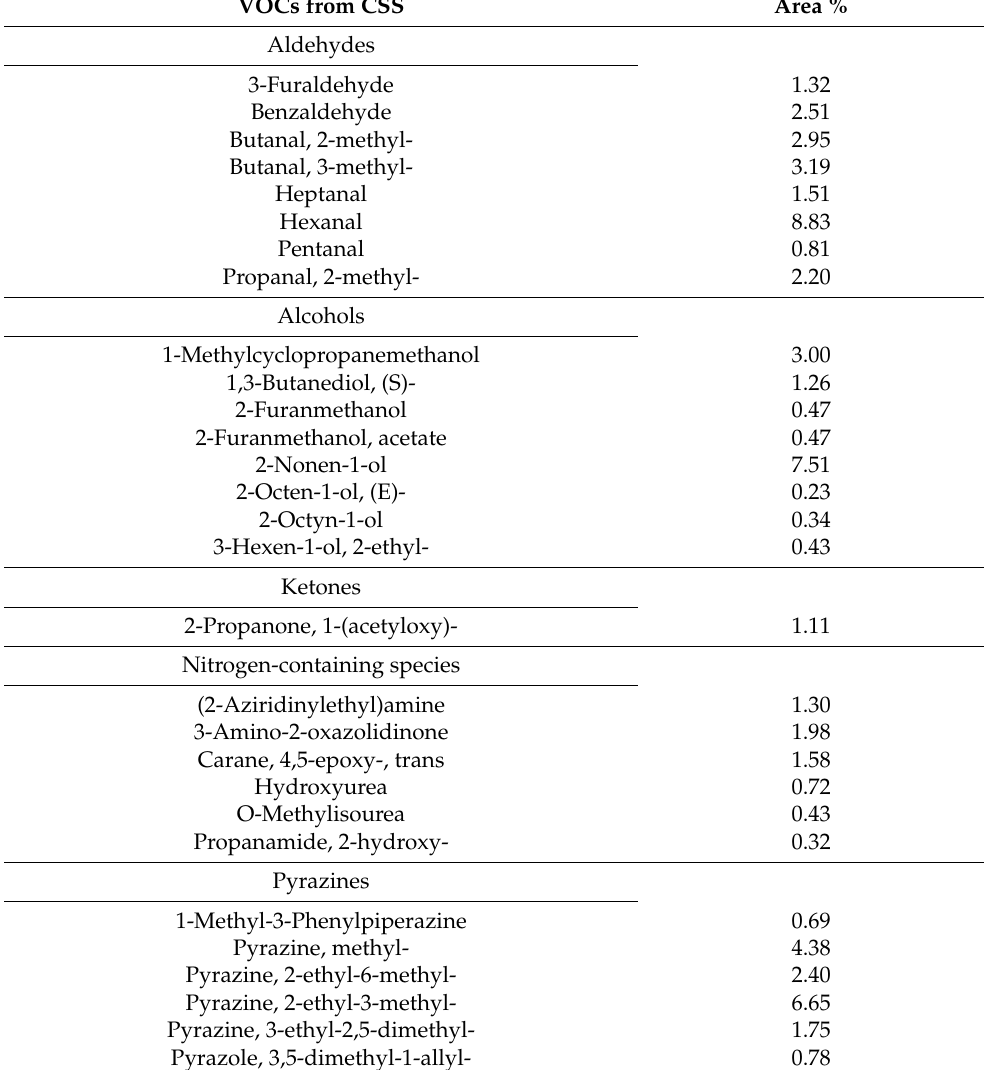
Table 5. Qualitative profile (area %) of main volatile compounds (VOCs) from CSS. VOCs from CSS Area %